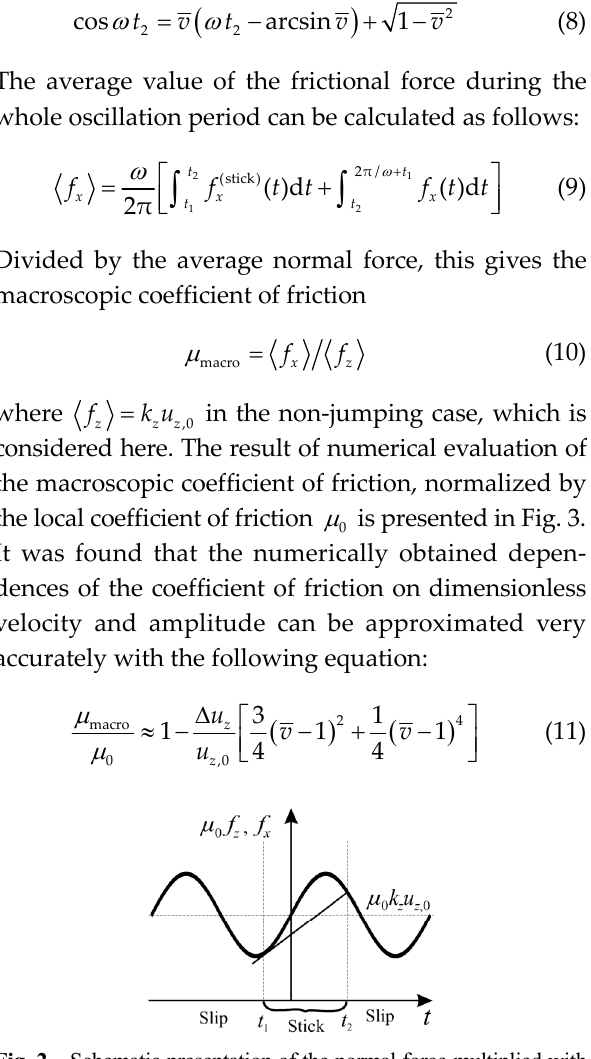
Fig. 2 Schematic presentation of the normal force multiplied with the coefficient of friction (sinusoidal curve) and tangential force (straight line). During the slip phase (before tangential force is equal to the normal force times the coefficient of friction, thus both curves coincide. During the stick phase (between t and t ), the tangential force is smaller than the normal force 1 2 multiplied by the coefficient of friction. Both forces become equal t , where the stick phase again at time 2